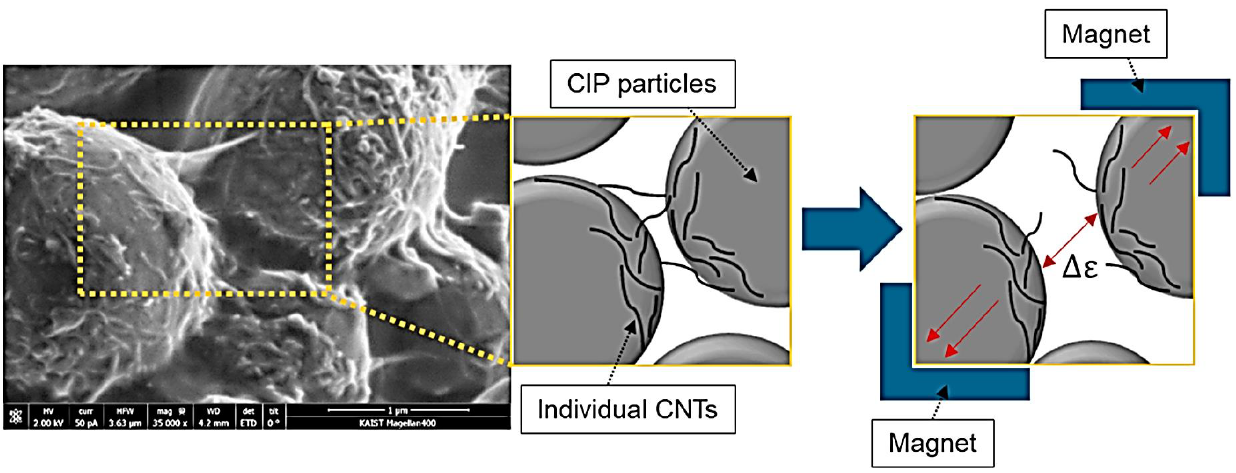
Figure 14. T he CNTs and CIP formation schematic under different magnetic fields [52]. Figure 14. The CNTs and CIP formation schematic under different magnetic fields